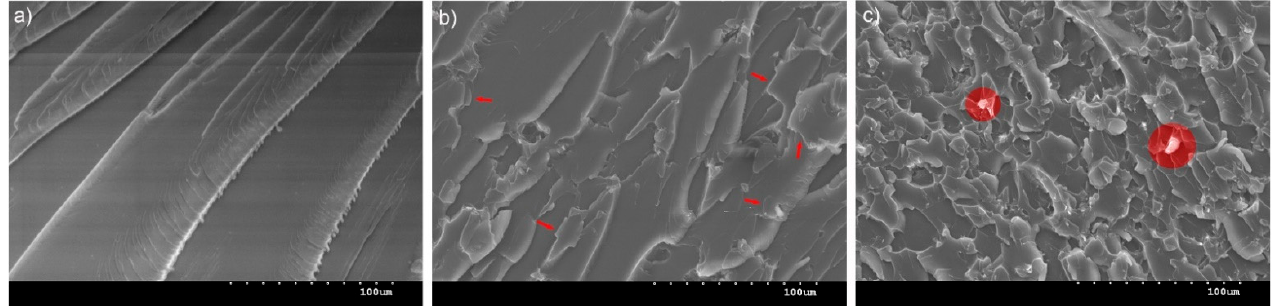
Figure 12. SEM images of fractured surfaces of ( a ) neat epoxy, ( b ) nanocomposite with 0.05 wt% rGO and ( c ) nanocomposite with 0.1 wt% rGO.